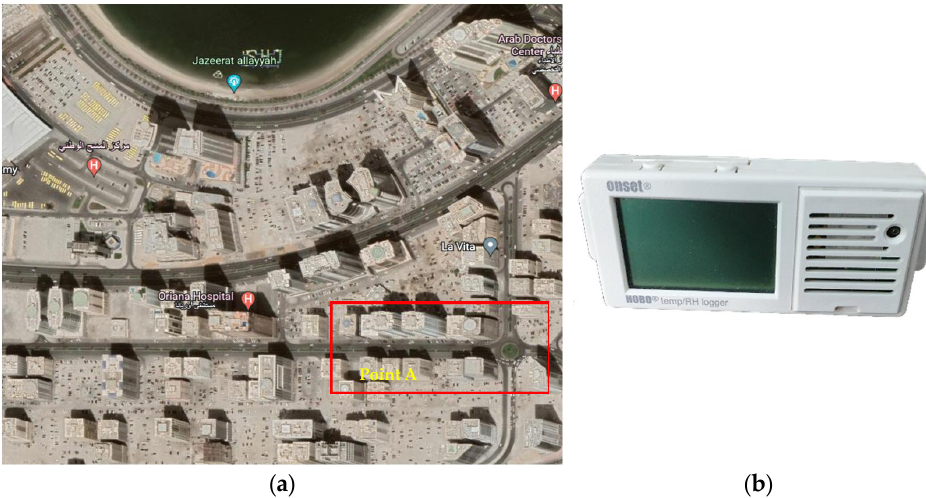
Figure 2. ( a ) The location of the selected point for validation by the simulation and measurements. (Google Earth) [33]; ( b ) the onset data logger, shown on the right (image by author).